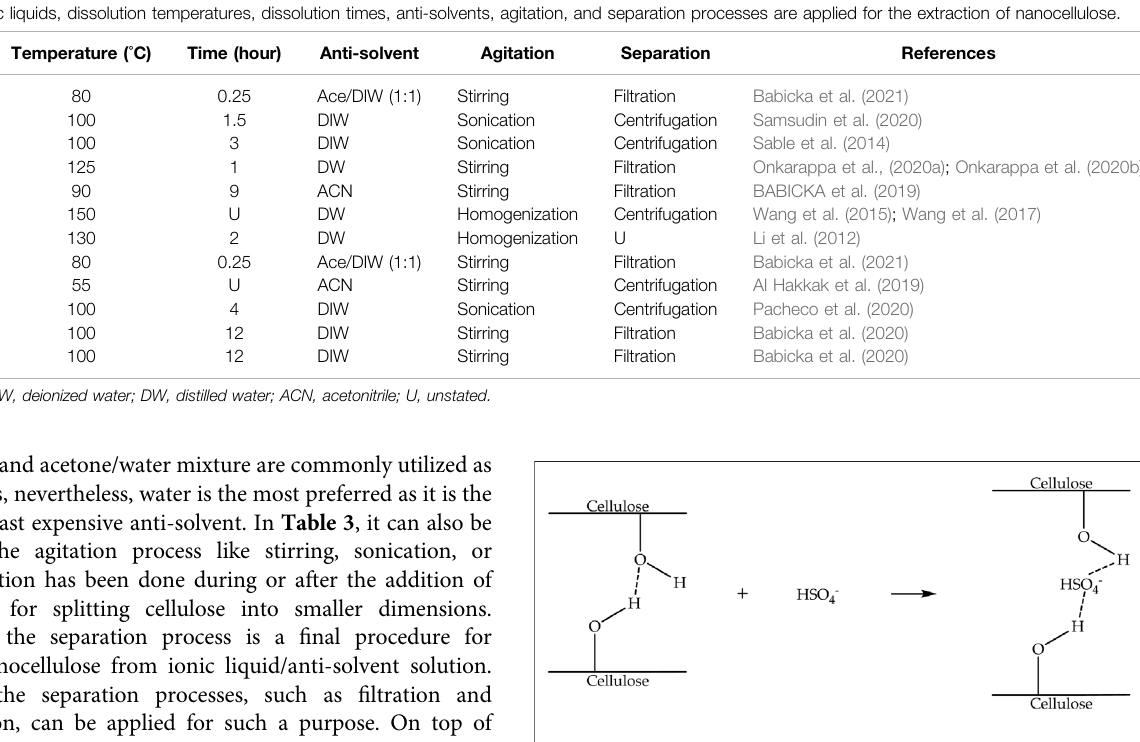
FIGURE 6 | Mechanism of the swelling process of cellulose with hydrogen sulfate anion-based ionic